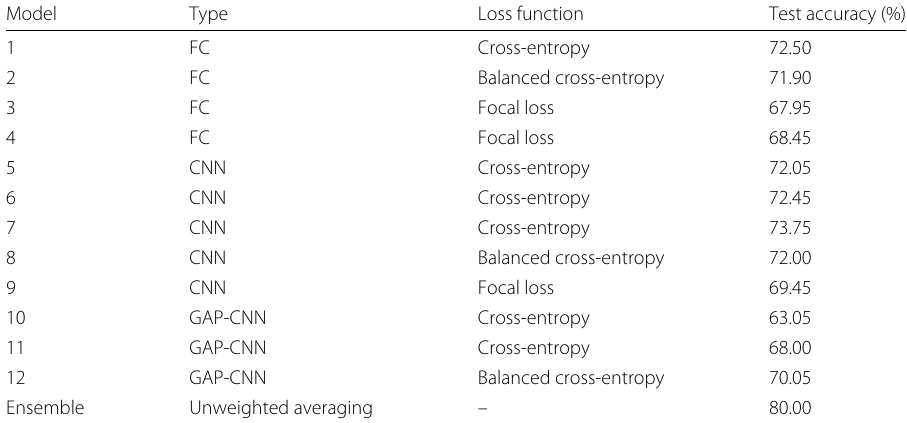
Table 1 Accuracies of the classifiers composing the ensemble